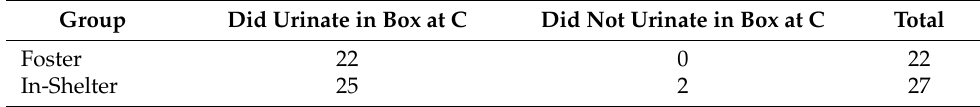
Table 3. Number of cats urinating in the litter box at time point C by group. Group Did Urinate in Box at